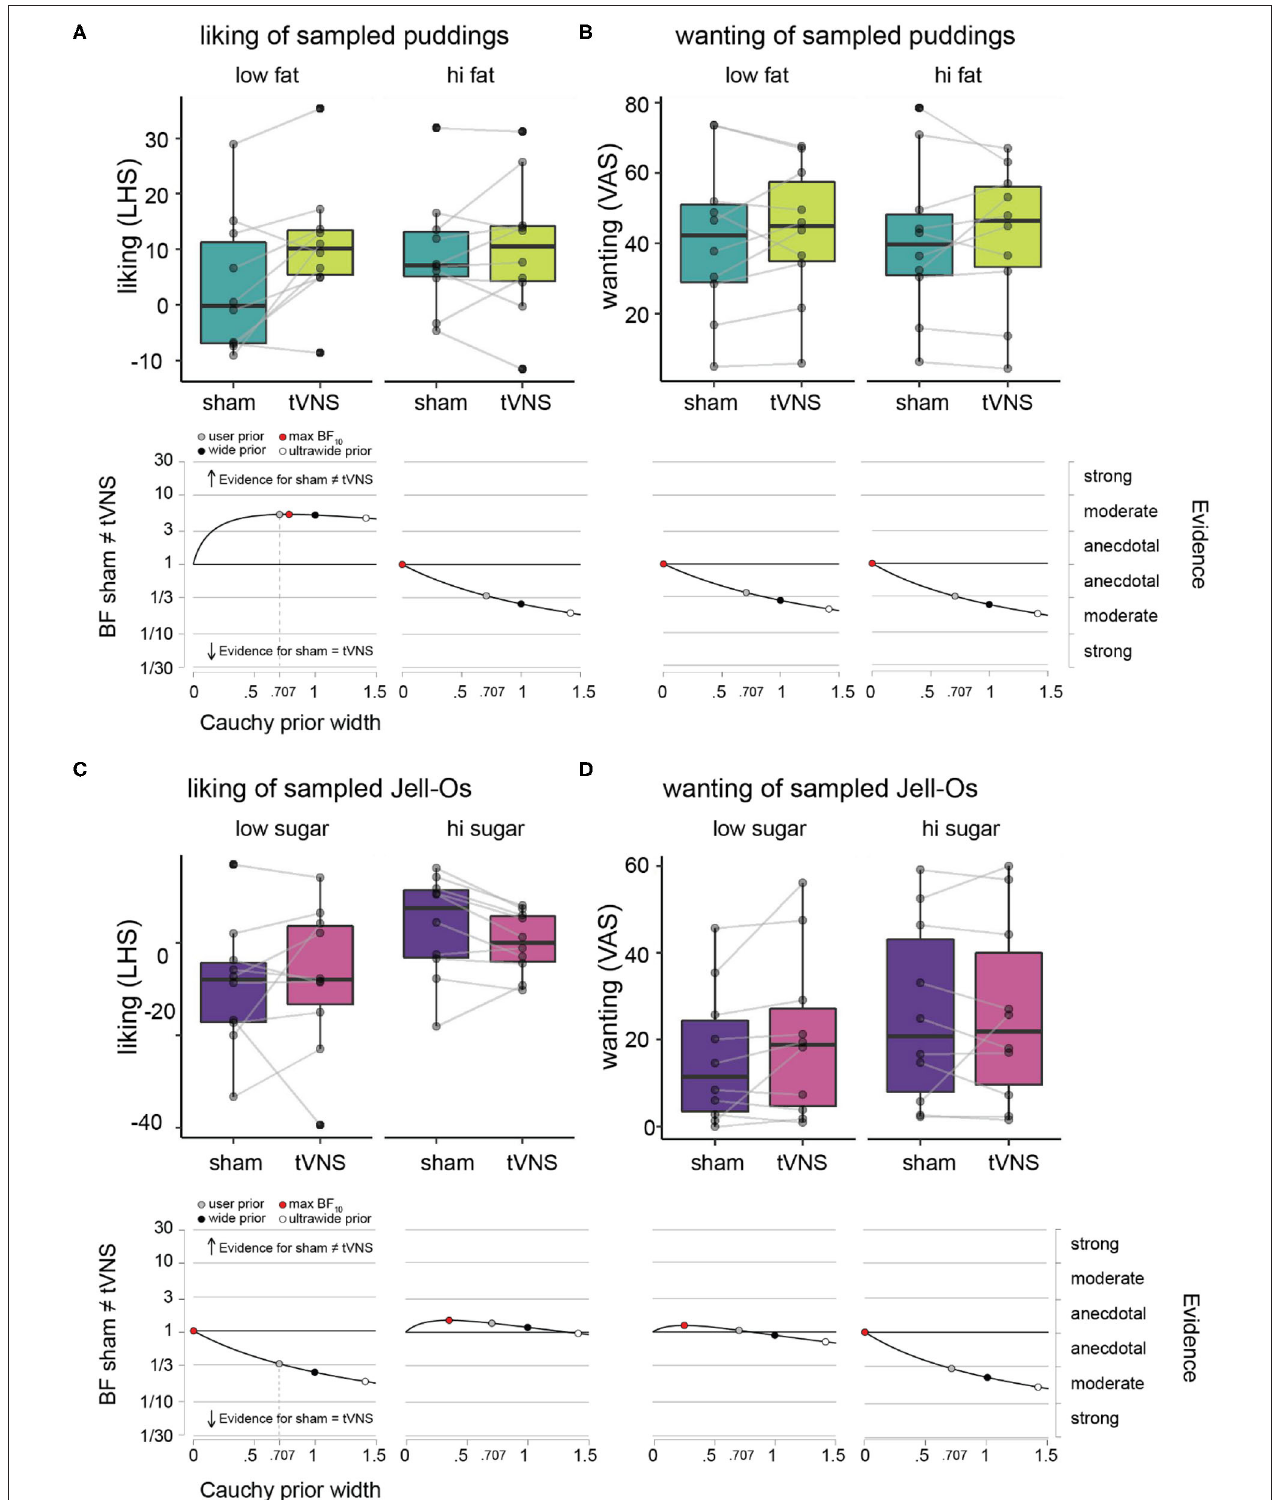
FIGURE 2 | Hedonic ratings of puddings and Jell-Os during sham vs. tVNS. (A) Liking ratings on LHS under sham (dark green) vs. tVNS (light green), plotted for the low fat puddings (upper left panel) and high fat puddings (upper right panel) separately. The boxplots indicate central tendencies and spread of the ratings, as follows: